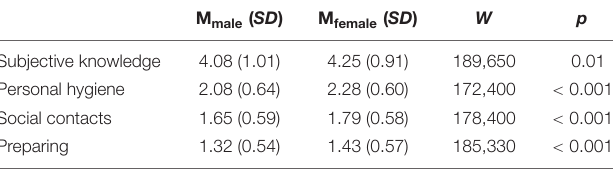
TABLE 2 | Mean scores and gender differences for subjective knowledge about self-protective behaviors and and engagement in self-protective behaviors. M male ( SD ) M female ( SD ) W p